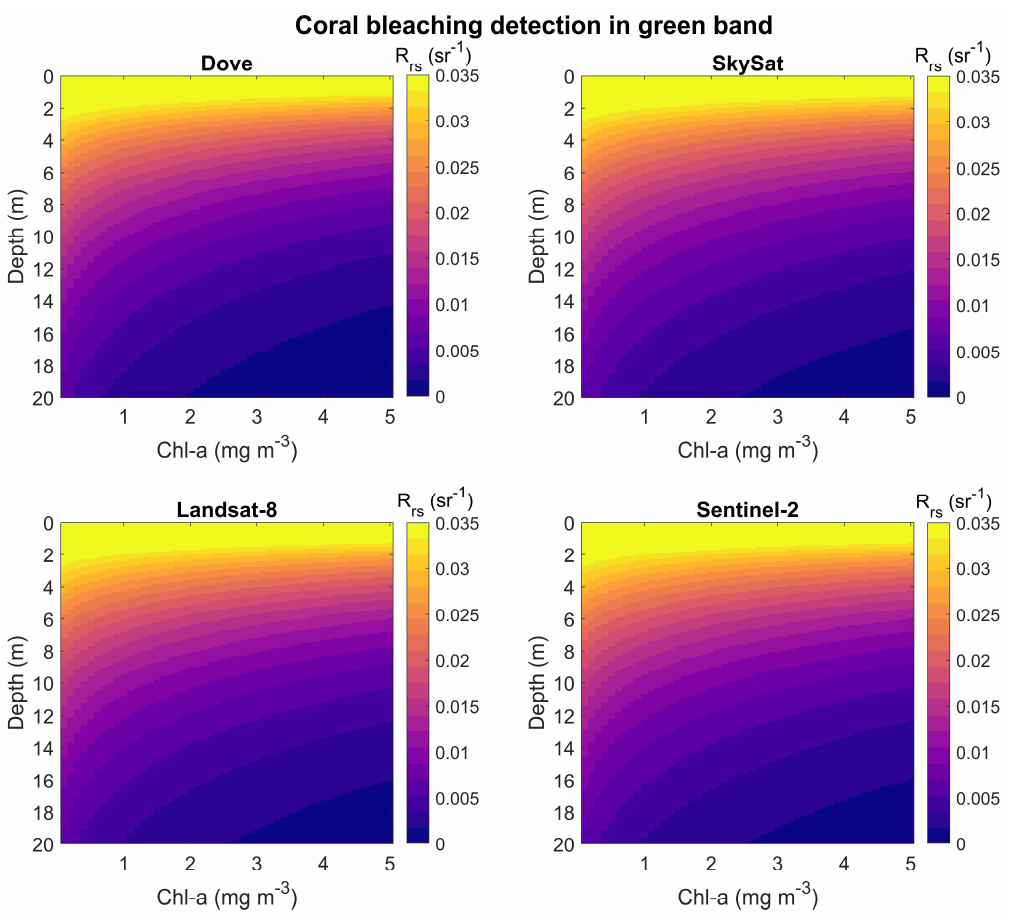
Figure 5. Differences in remote sensing reflectance between bleached and live coral in the green spectral bands of four different satellite sensors.